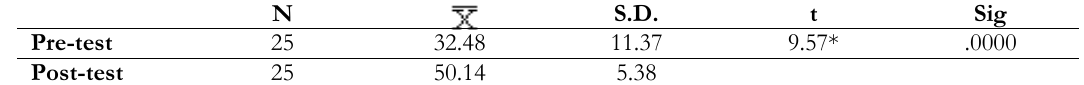
TABLE 6. A Comparison of the Scores between the Pre- and Post-Tests N S.D. Sig